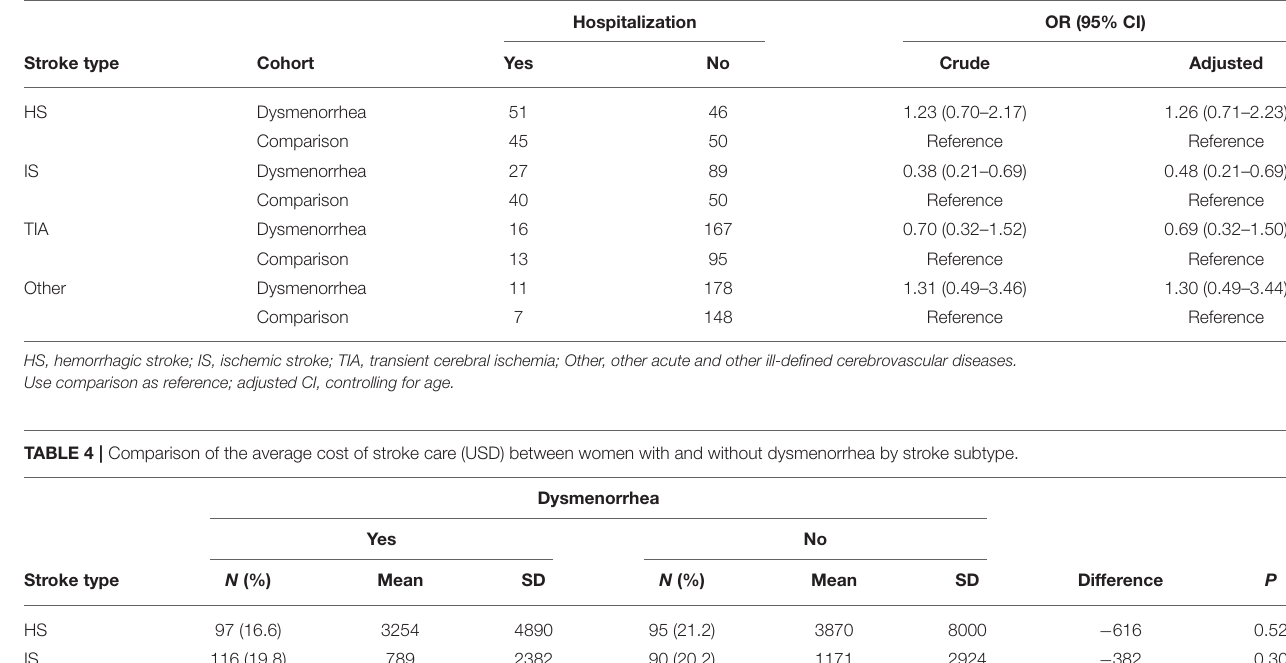
TABLE 3 | Estimated risk of hospitalization for stroke in women with dysmenorrhea compared to women without dysmenorrhea by the subtype of stroke.